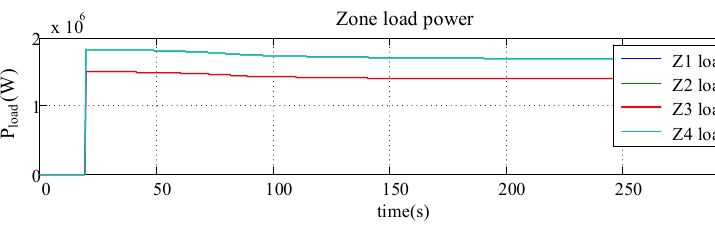
Figure 8. Case 1 zonal loads power.